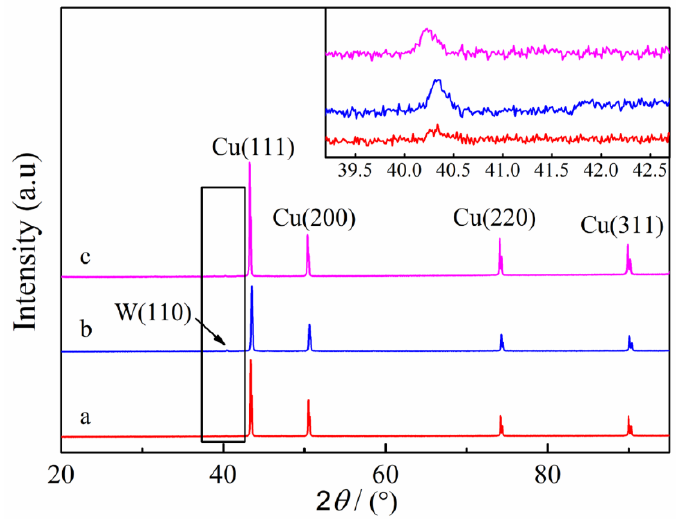
Figure 11. XRD patterns of W – Cu composite under different reverse duty cycles: ( a ) d r = 5%, ( b ) d r = 10%, and ( c ) d r = 15%, ( J = 2 A/dm 2 , f = 1500 Hz and d f = 40%).